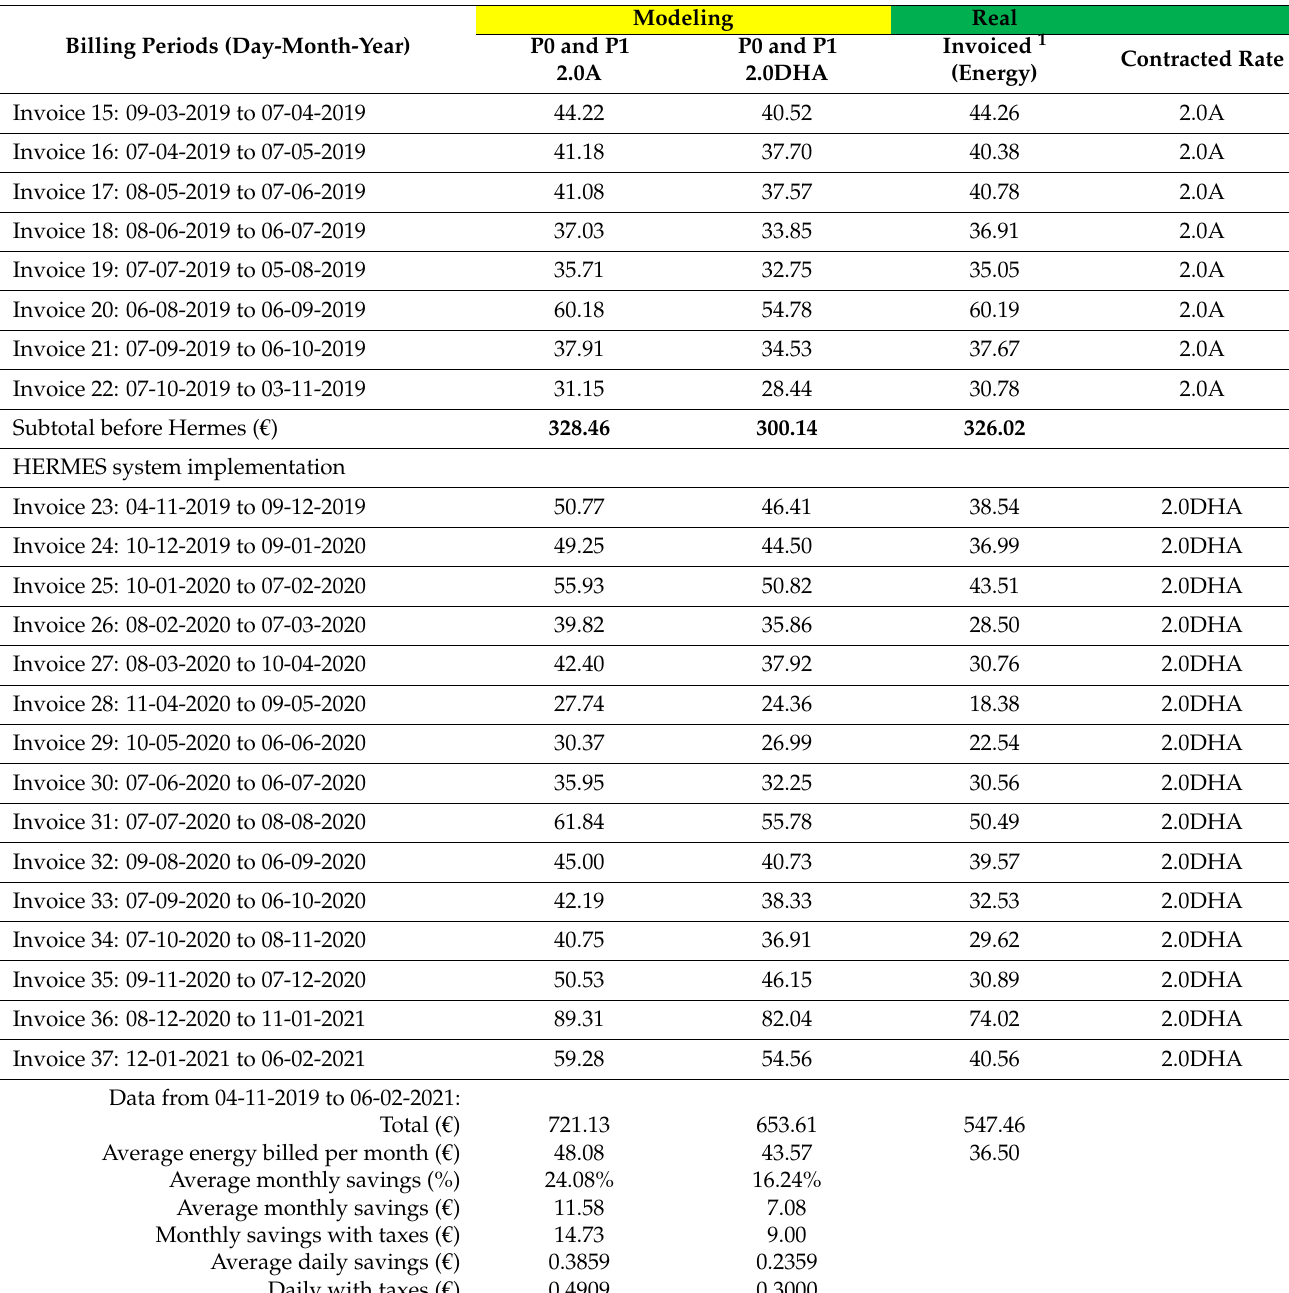
Table 6. Cost of energy consumed ( € ) by billing months for the scenario without load shifting or behavioral adaptation (P0P1 series) and actual billed cost. The data are divided into modeled and real data. Billing Periods